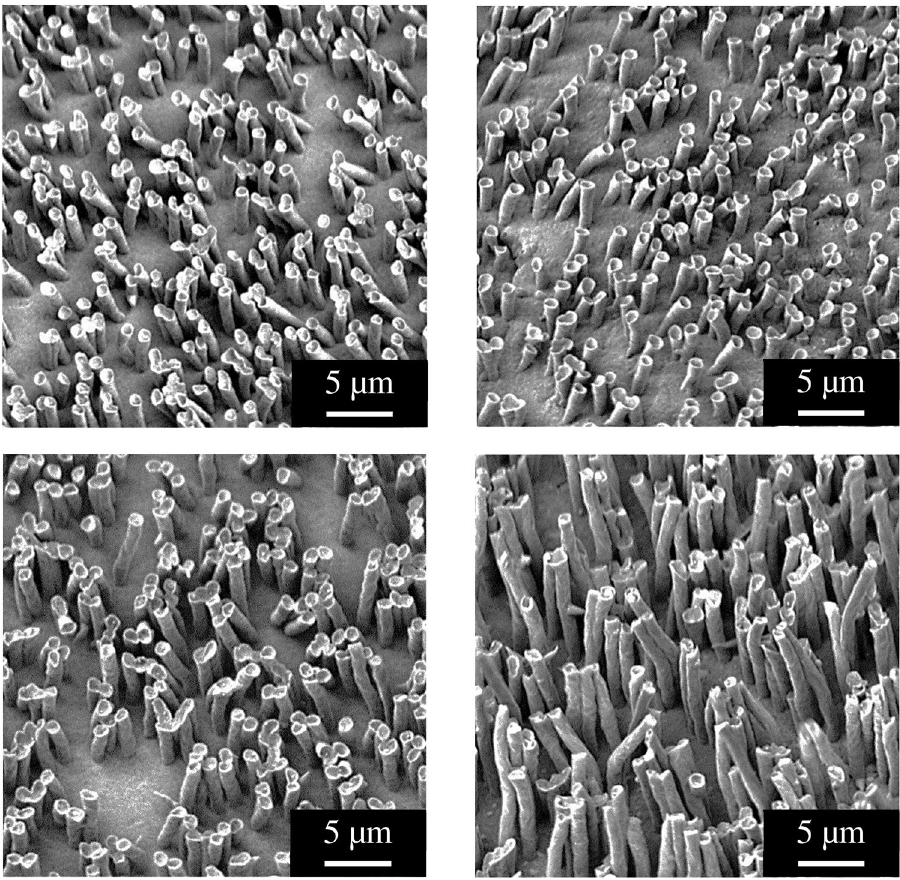
Figure 3. SEM images of HDPE structures after filling of the pores by capillary action (T: 170 °C), cooling down and dissolution of the PC membrane in dichloromethane (chemical demolding); contact times: ( a ) 30 s, ( b ) 60 s, ( c ) 300 s and ( d ) 600